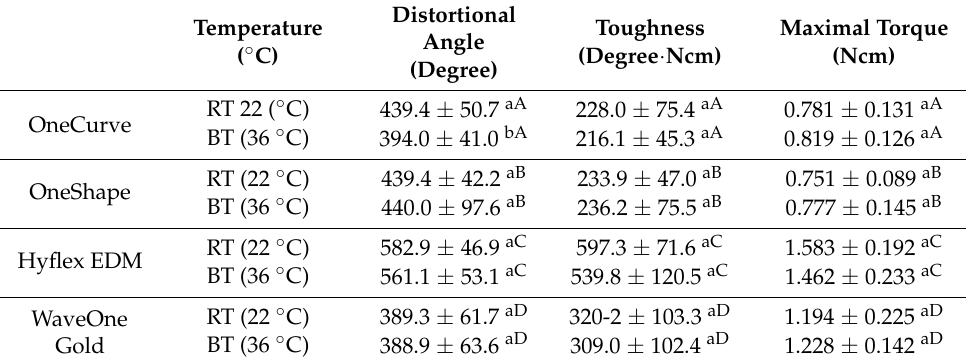
Table 2. The results of torsional resistance (mean ± standard